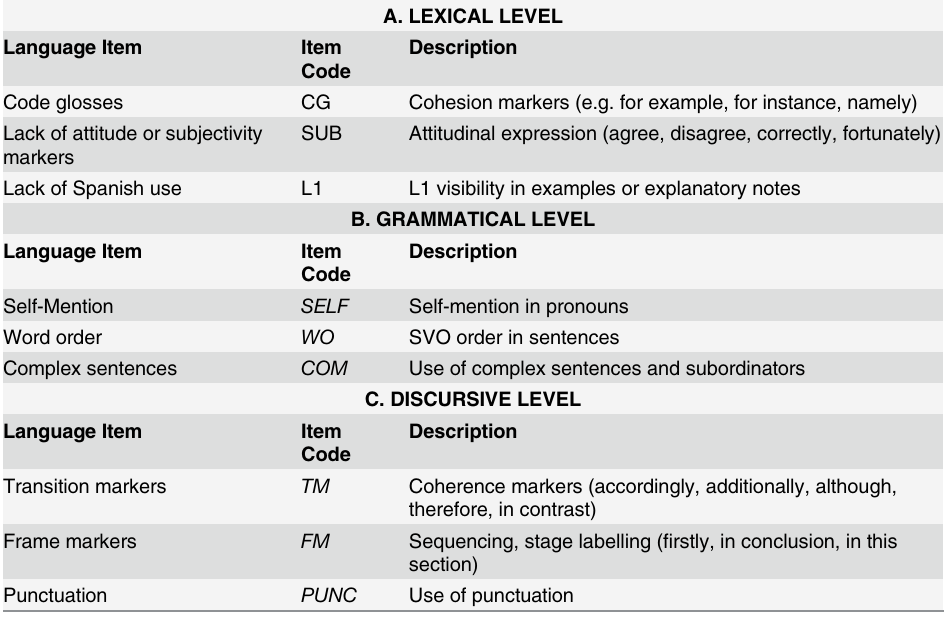
Table 2. List of items to be examined in each